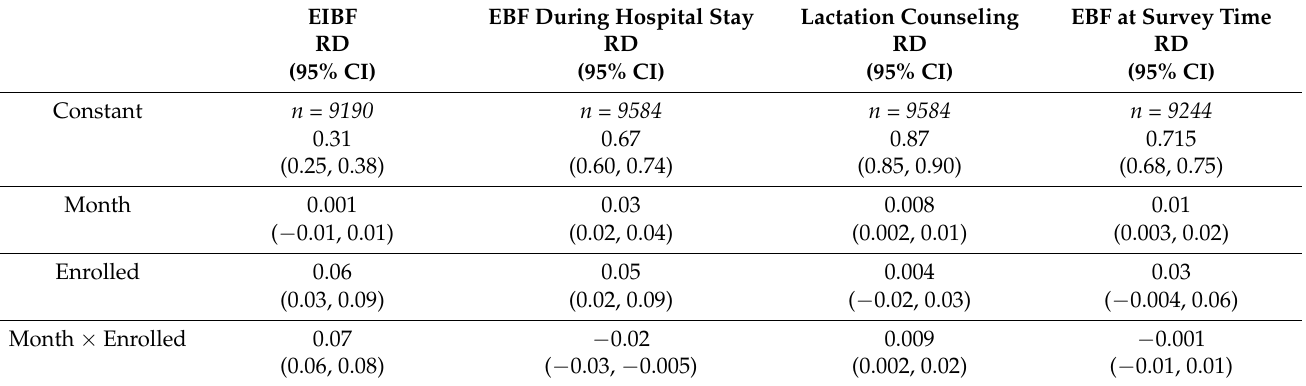
Figure 1. Rates of the main outcomes relative to timing of hospital enrollment. ( A ) Early initiation of breastfeeding in the hospital; ( B ) EBF in the hospital; ( C ) receiving lactation counseling in the hospital; ( D ) EBF at time of survey. Table 2. Risk difference from segmented regression